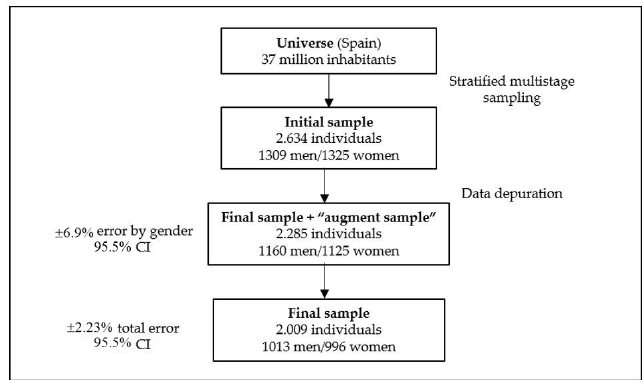
Figure 1. Sample collection design for the ANIBES study.